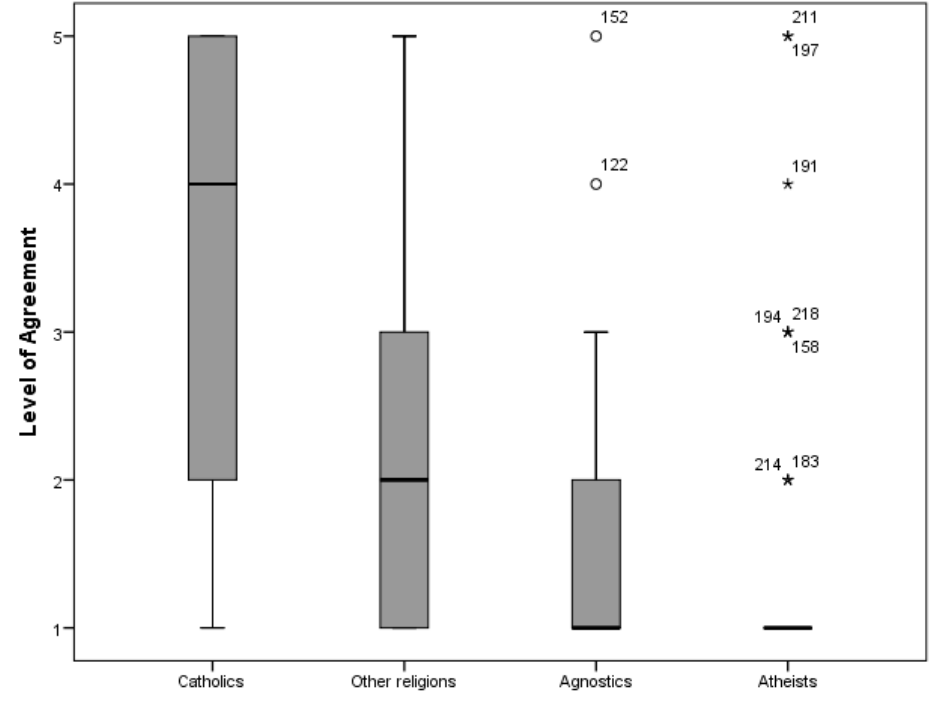
Figure 3. Box-plots showing degree of agreement for different religious groups on rejecting abortion (dots and asterisks indicate outliers and very atypical values).